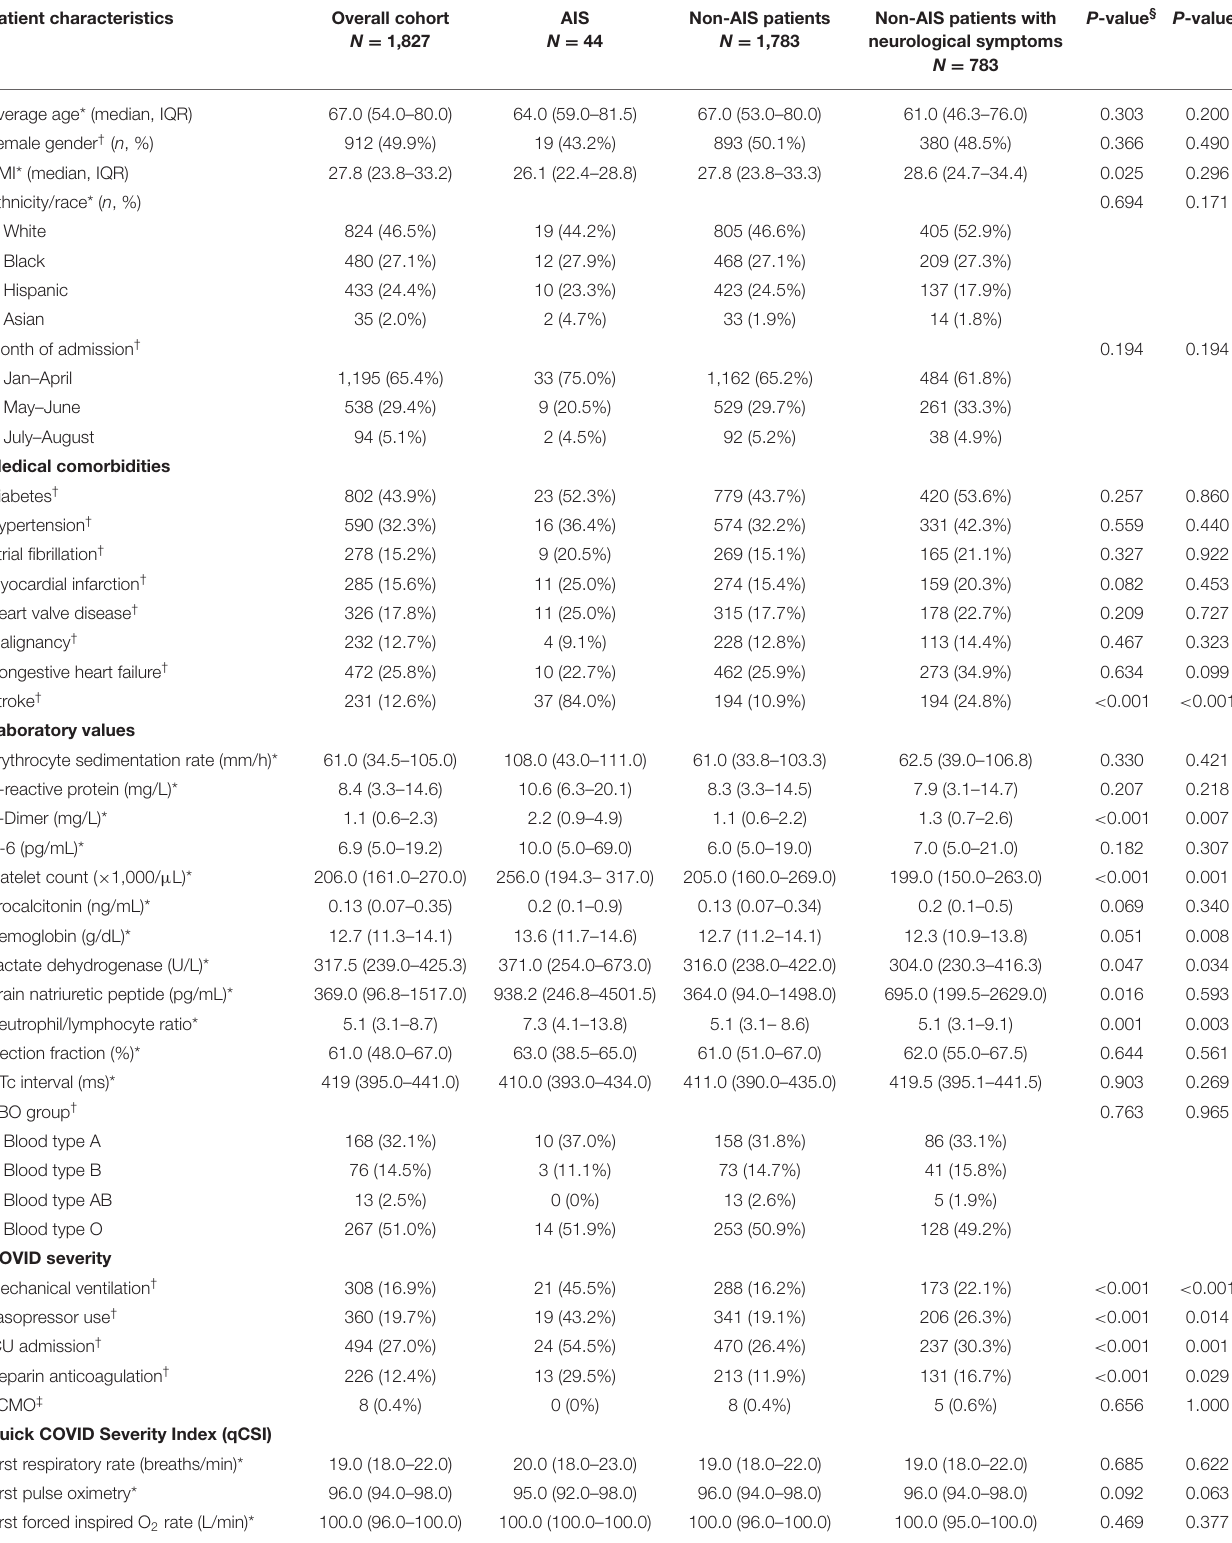
TABLE 1 | Characteristics of patients with COVID-19 with and without ischemic stroke in the derivation cohort. Patient